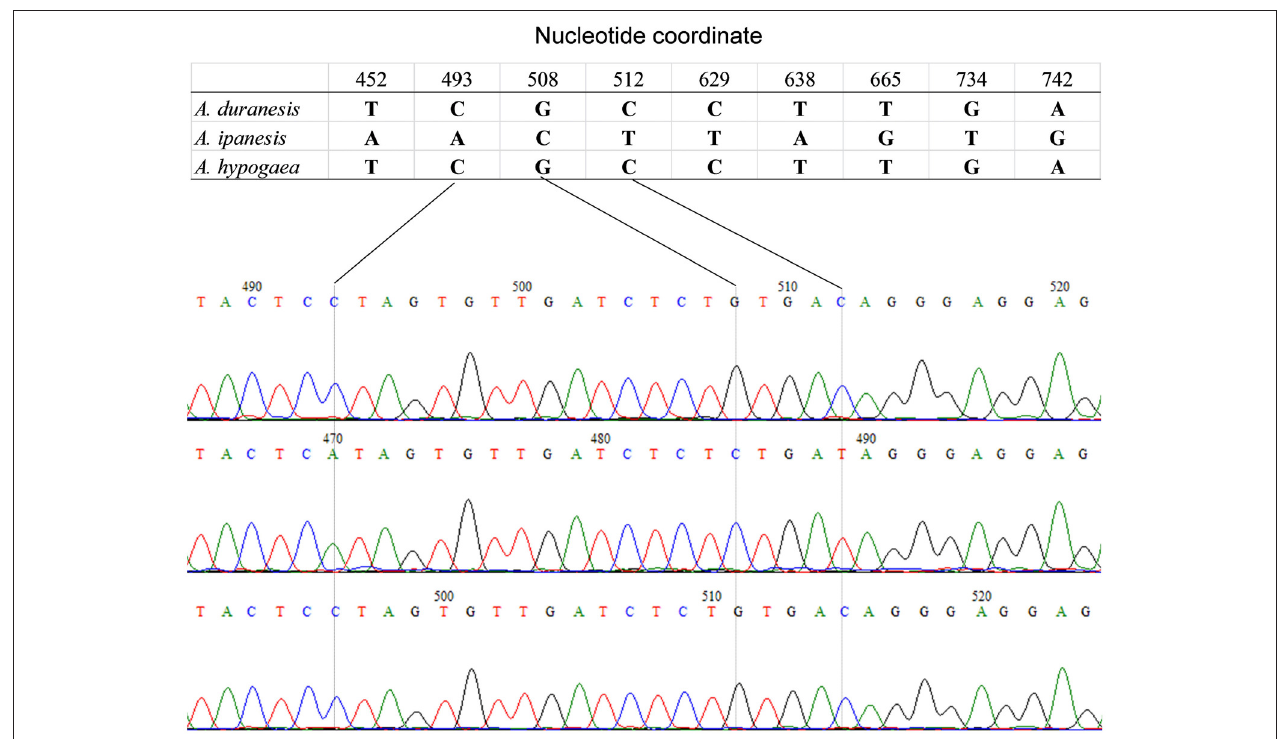
FIGURE 2 | Amplicon Sequence of EST-86 in A. hypogaea and putative diploid progenitor. The figure shows that the A. duranensis and A. ipaensis genomes each contained single copy of sequence “EST-86” while single copy from A. duranensis genome retained in A. hypogaea